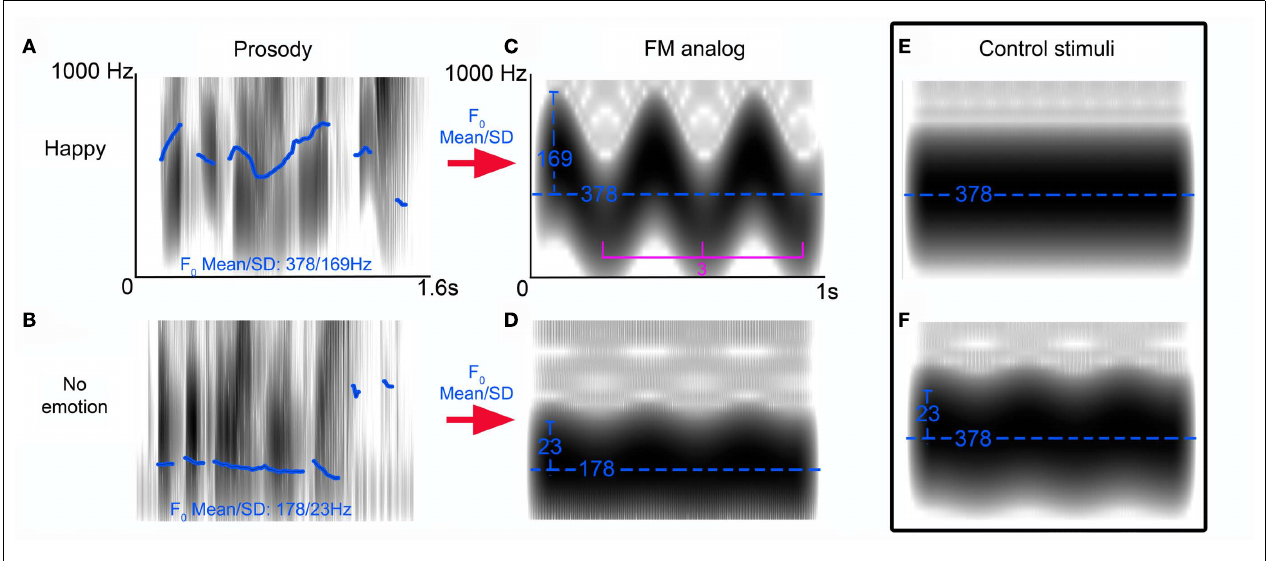
FIGURE 1 | Frequency-modulated (FM) tone stimuli profile. Spectrograms of reliably recognized prosodic sentences (“is it eleven o’clock?”) spoken with a happy (A) or no emotional (B) intonation. Pitch differences between stimuli are indicated by fundamental frequency ( F 0 ) contour (blue trace) as calculated byTDPSOLA algorithm in PRAAT. Using the F 0 mean and SD of these stimuli